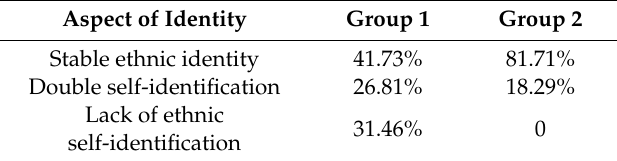
Table 2. The individual ethnic self-identification of the respondents (n1 = 100, n2 = 100).